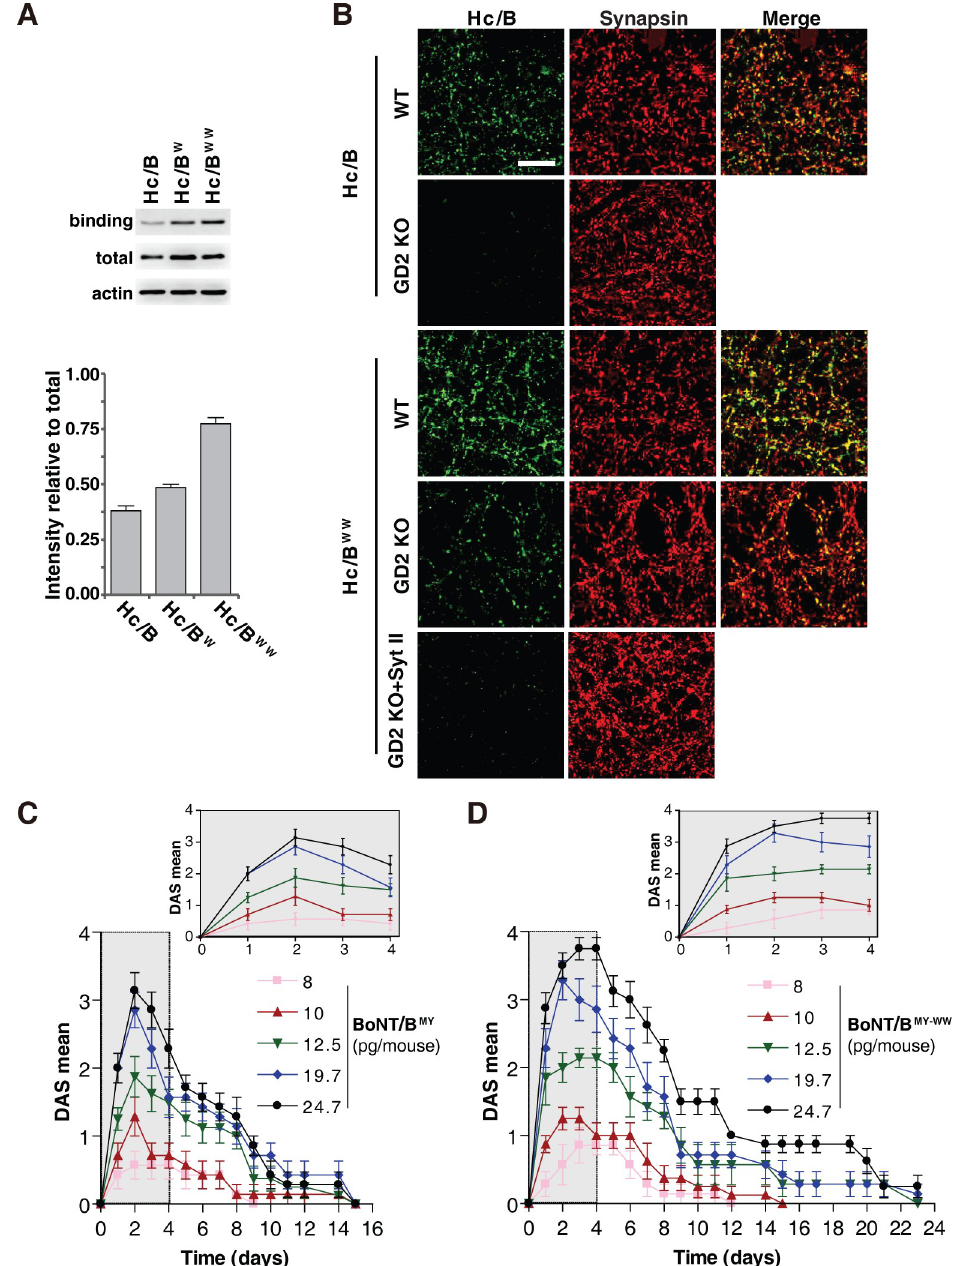
Fig 5. Characterizing binding of H C /B WW on cultured neurons and BoNT/B MY-WW in vivo. (A) Binding of WT H C / B, H C /B W , and H C /B WW to cultured rat cortical neurons was examined by immunoblot analysis. Neurons were exposed to HA-tagged H C /B, H C /B W , and H C /B WW for 5 minutes, washed, and harvested for immunoblot analysis. Actin served as an internal loading control. The total represents 50 ng of H C proteins. Representative blots and the intensity relative to total H C /B quantification results are shown. (B) Binding of H C /B and H C /B WW to cultured mouse cortical WT and GD2 KO neurons was examined by immunostaining analysis. Neurons were exposed to HA-tagged H C /B, H C /B WW , or H C /B WW plus GST-tagged recombinant Syt II (1–61, 10-fold of H C /B WW concentration) for 5 minutes, washed, fixed, and subjected to immunostaining analysis. Synapsin serves as an internal marker for presynaptic terminals. H C /B WW showed enhanced binding to neurons compared with H C /B and colocalized with Synapsin. Binding of H C /B WW is lower on GD2 KO neurons compared with WT neurons, and residual binding of H C / B WW on GD2 KO neurons is eliminated by recombinant Syt II fragment protein as a receptor decoy. Scale bar represents 30 μ m. (C) The control BoNT/B MY elicited a dose-dependent response in the DAS mean score. Data are